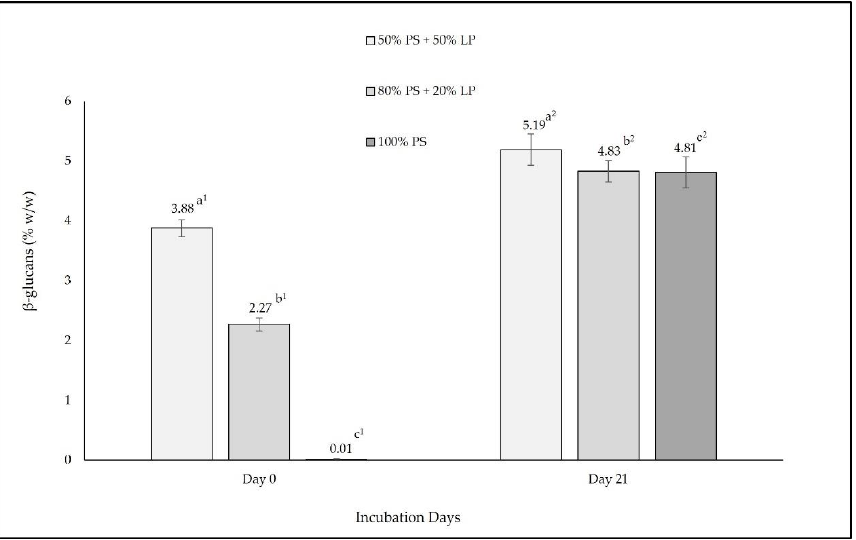
Figure 11. Evaluation of β -glucans content for PS and its mixtures with LPs. Statistical analysis was performed for each substrate individually between Day 0 and Day 21. Different superscripts between the same letters indicate statistical significance ( p ≤ 0.05).